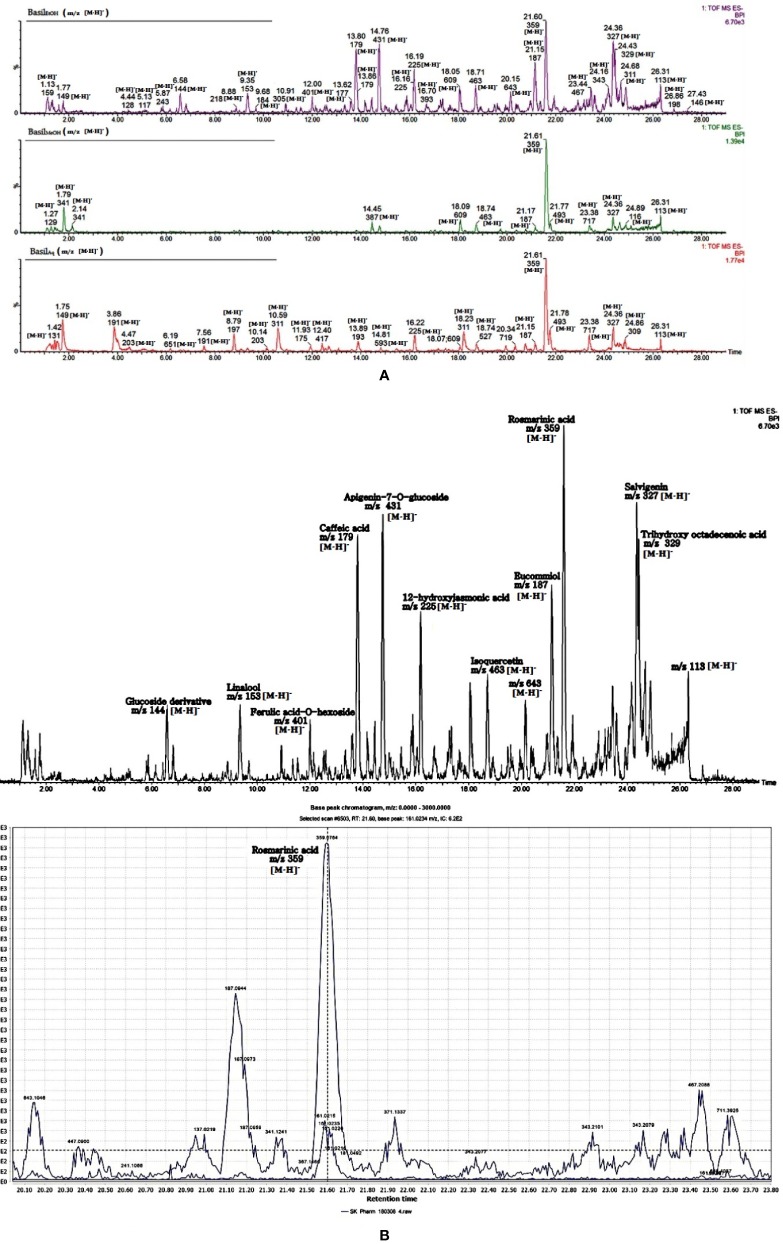
(A) LC-MS chromatogram of basil extracts in negative mode scan for time duration of 29 min. (B) LC-MS chromatogram of basil (ethanol extract) in negative mode scan for time duration of 29 min, LC-MS spectra focusing on rosmarinic acid [m/z 359.0764 (M-H)-].